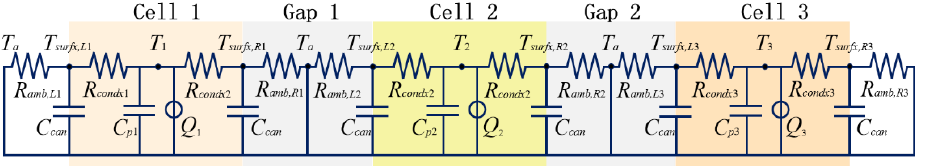
Figure 4. Battery pack thermal resistance network diagram.